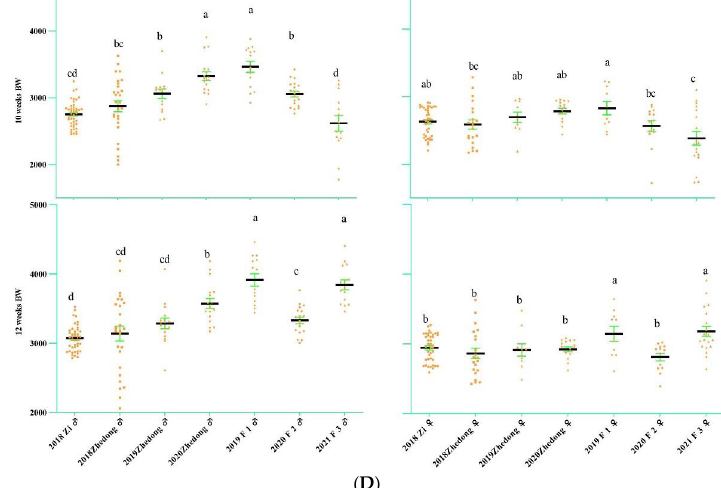
Figure 2. Changes in the goose egg-laying trait and body weight in different generations. ( A ) Heat map of goose egg-laying data of different generations. The different colors represent different laying rates, and the abscissa is initially dated 21 February. The end time is 3 July; the total number of days is 133. On 29 February 2020, the experimental group did not start laying eggs. ( B ) Growth data of different generations of geese (0–4 weeks) ( C ) Growth data of different generations of geese (6–8 weeks) ( D ) Growth data of different generations of geese (10–12 weeks). The body weight of the F3 hybrids shows significant differences at 2 weeks and 12 weeks. The different letters indicate significant differences. The green bar represents SE. Body-weight unit: g.